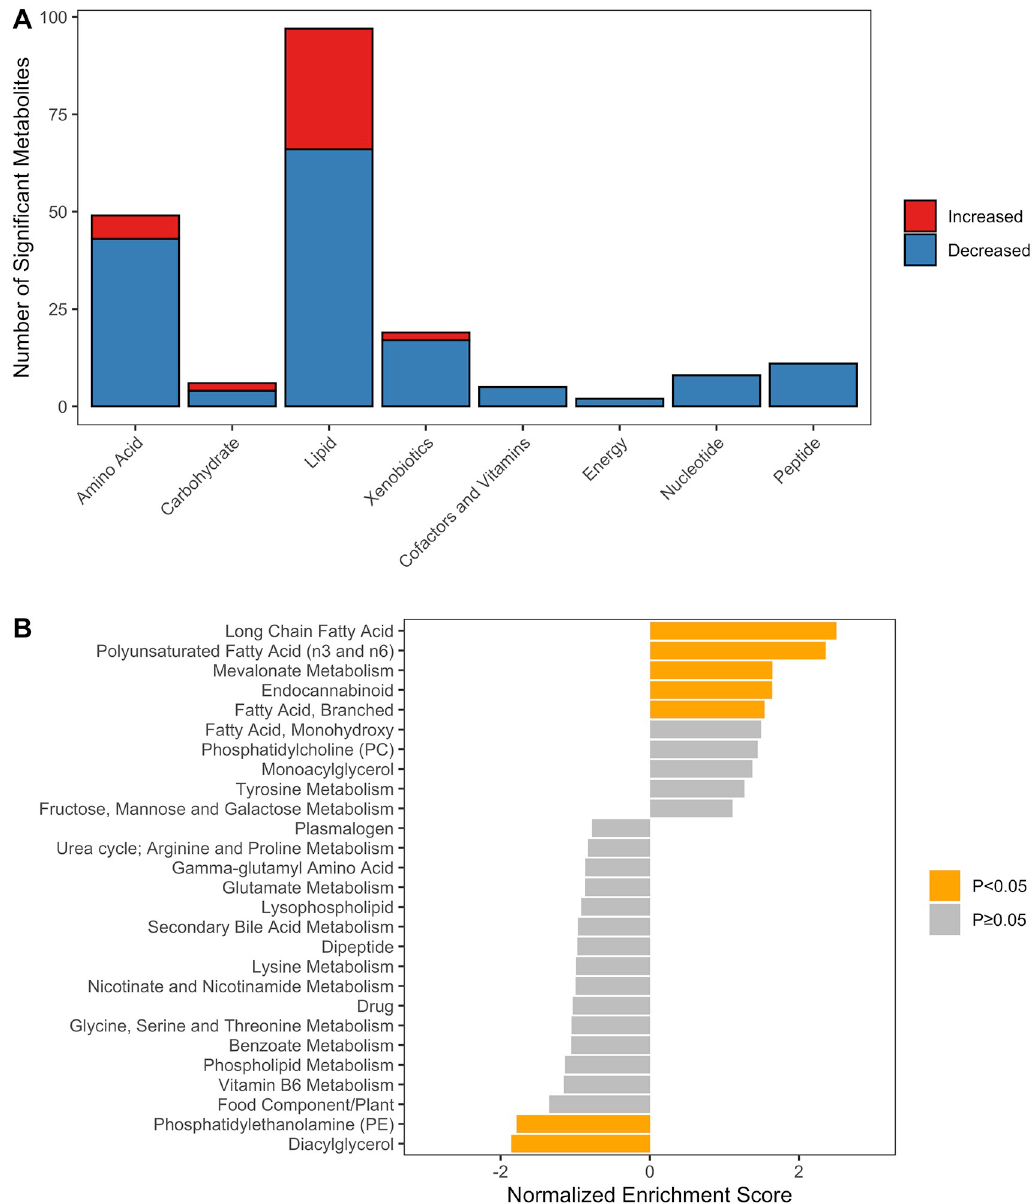
Fig 2. Metabolite set enrichment analysis. A. Representation of metabolic super pathways among metabolites that varied significantly between the EPI and healthy control groups. B. Metabolite set enrichment analysis (MSEA) was used to detect significantly enriched metabolic sub-pathways in cats with EPI. The normalized enrichment score (NES) represents the degree to which a metabolic sub-pathway is over-represented at the top or bottom the list of ranked metabolites. A positive NES means that a metabolic sub-pathway is up-regulated in EPI and a negative NES means that it is down-regulated. The color of the bar representing NES is orange for significantly altered pathways (P < 0.05) and grey for those that were not significantly altered (P �